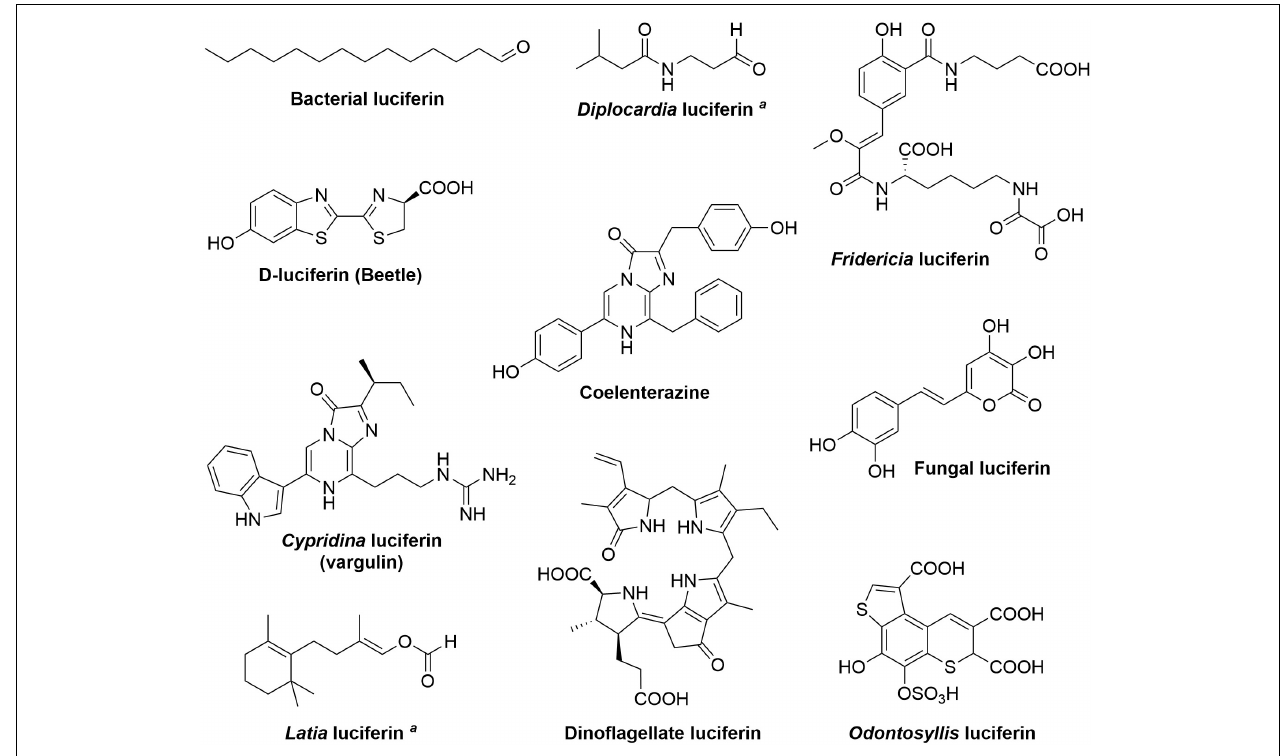
FIGURE 1 | Structures of known luciferins. a The structure of the light-emitting species is still